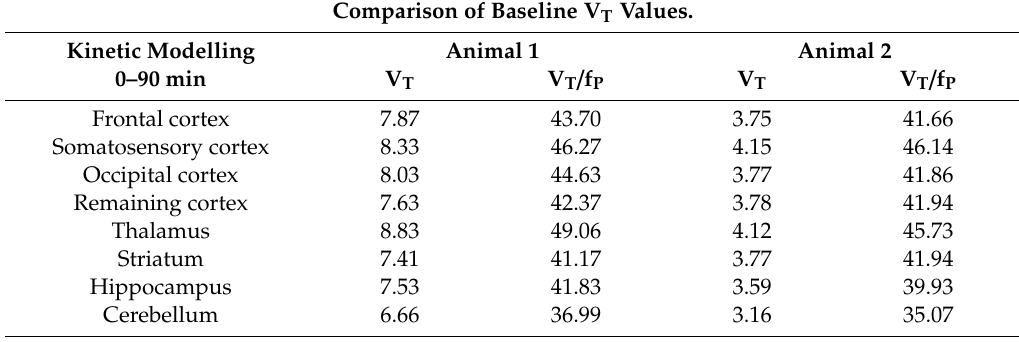
Table 3. Kinetic modelling of [ 18 F]ASEM with the Logan Graphical Analysis model in di ff erent pig brain regions. Comparison of Baseline V T